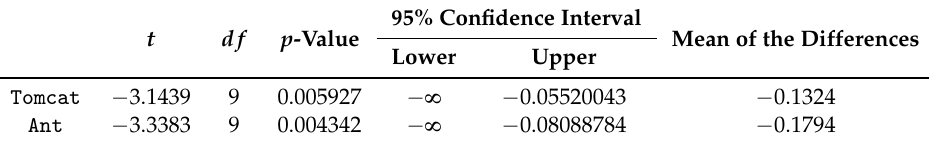
Table 6. The paired samples t -test for the Tomcat and Ant